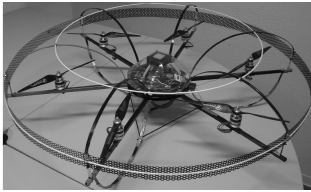
Figure 1: Hexacopter in use in the I3S